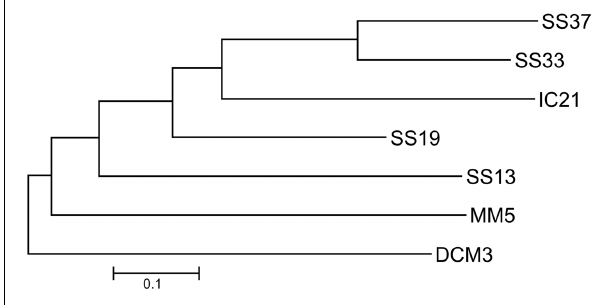
FIGURE 1 | Unrooted neighbor-joining phylogenetic tree based on a distance matrix calculated using “bit-scores” between the different metagenomes. DCM3: Deep Chlorophyll Maximum, Mediterranean Sea (3.8% salinity), MM5: Mar Menor Coastal Lagoon (5% salinity), IC21: Isla Cristina saltern (21% salinity), SS13: Santa Pola saltern (13% salinity), SS19: Santa Pola saltern (19% salinity), SS33: Santa Pola saltern (33% salinity), and SS37: Santa Pola saltern (37%